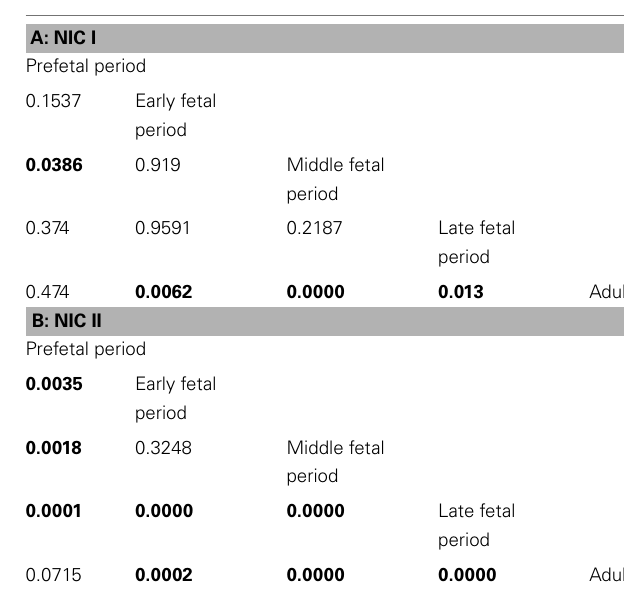
Table 4 | P -values in the Mann–Whitney tests of the variance of NIC numbers during various stages of human